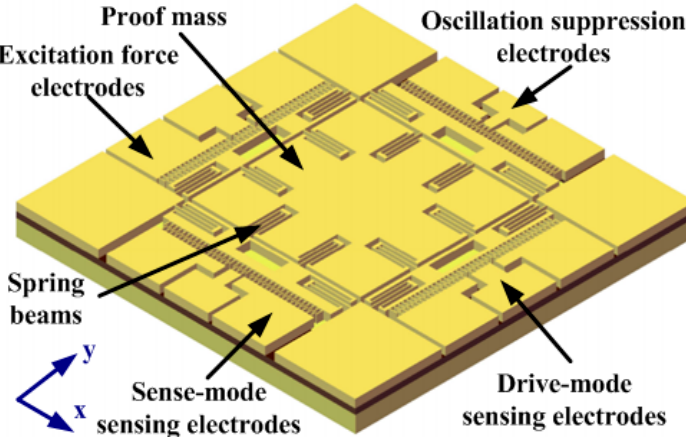
Figure 1. Schematic representation of the micro-machined Coriolis vibratory gyroscope (MCVG).